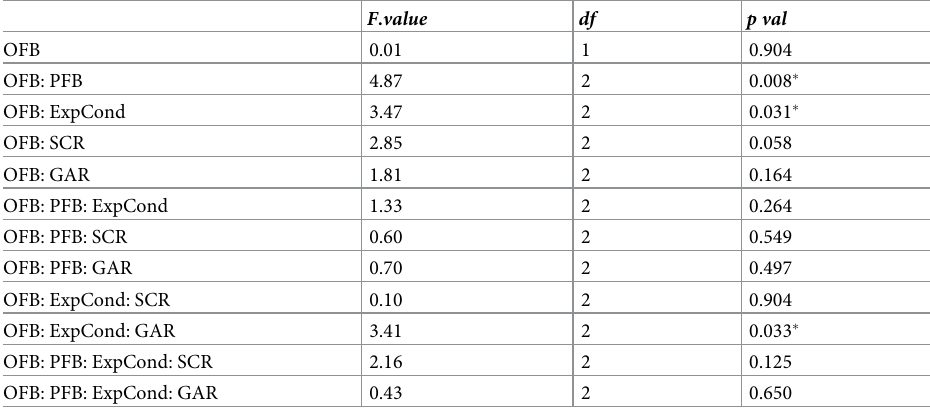
Table 3. Summaries of the type III analysis of variance for